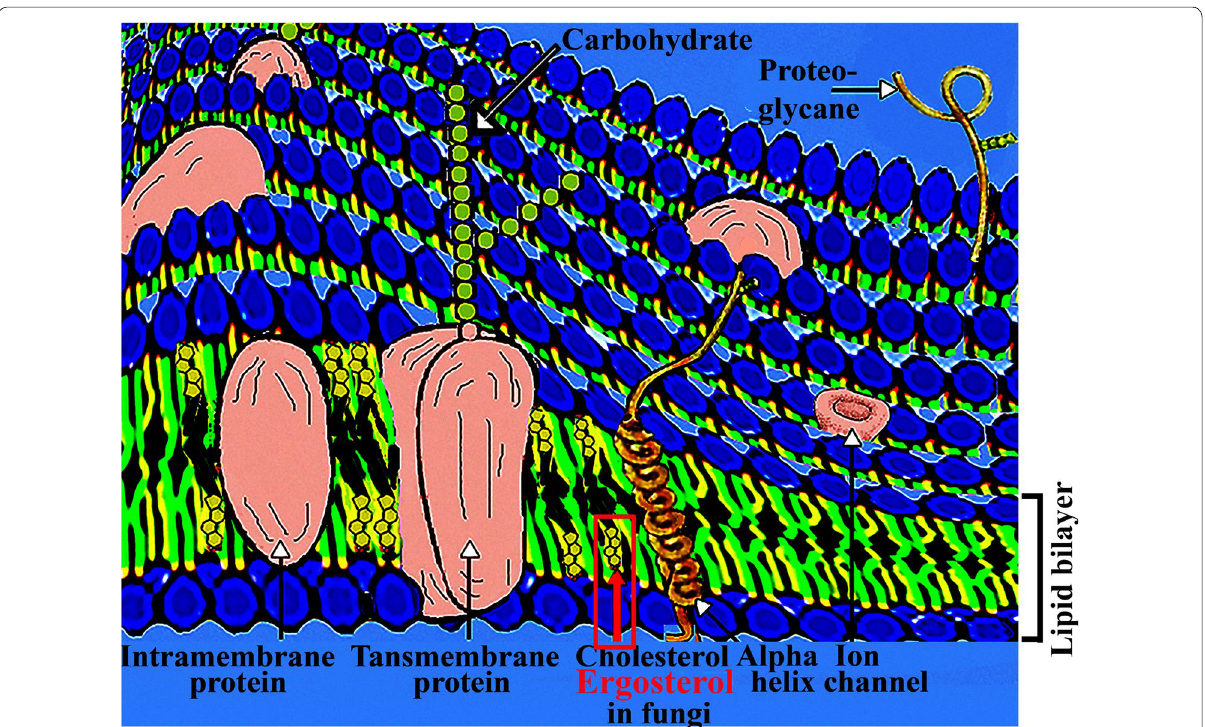
Fig. 4 Cellular membrane of eukaryotic cells with embedded intramembrane and transmembrane proteins, cholesterol, alpha helix, ion channel, glycoproteins containing carbohydrates. Ergosterol replaces cholesterol in fungi and protozoans (Modified with permission (Banfalvi